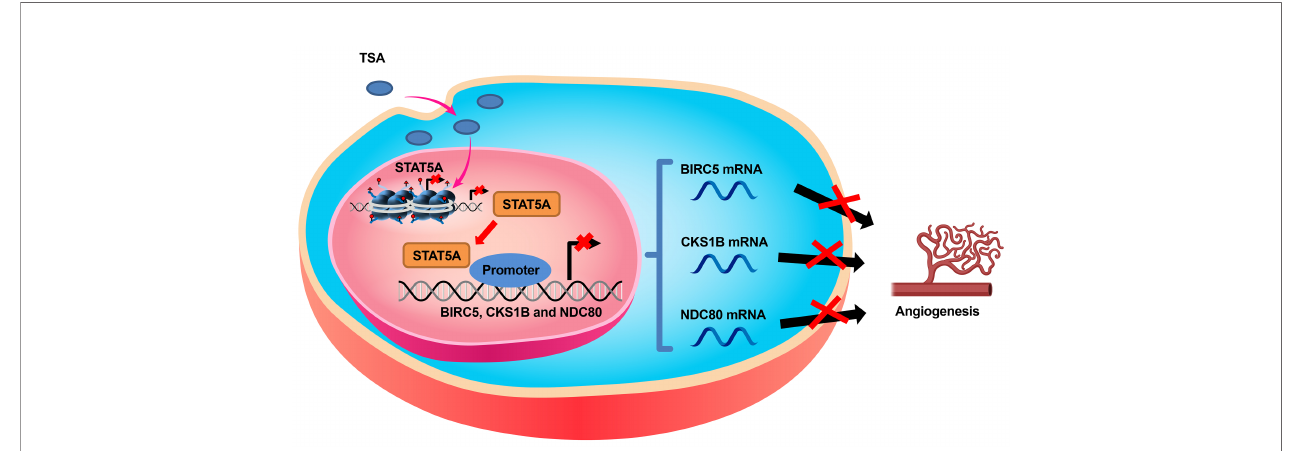
FIGURE 7 | Schematic diagram of the mechanism by which TSA inhibits the expression of BIRC5 , CKS1B , and NDC80 through suppressing STAT5A, resulting in angiogenesis suppression of